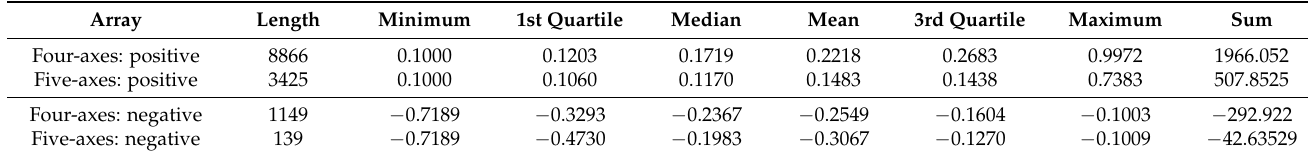
Table 2. Length, quartiles, mean, and sum comparison of the distance arrays. Lengths are the number of values, minimum, 1st quartile, median, mean, 3rd quartile, and maximum are in millimetres, and the sum is an arbitrary